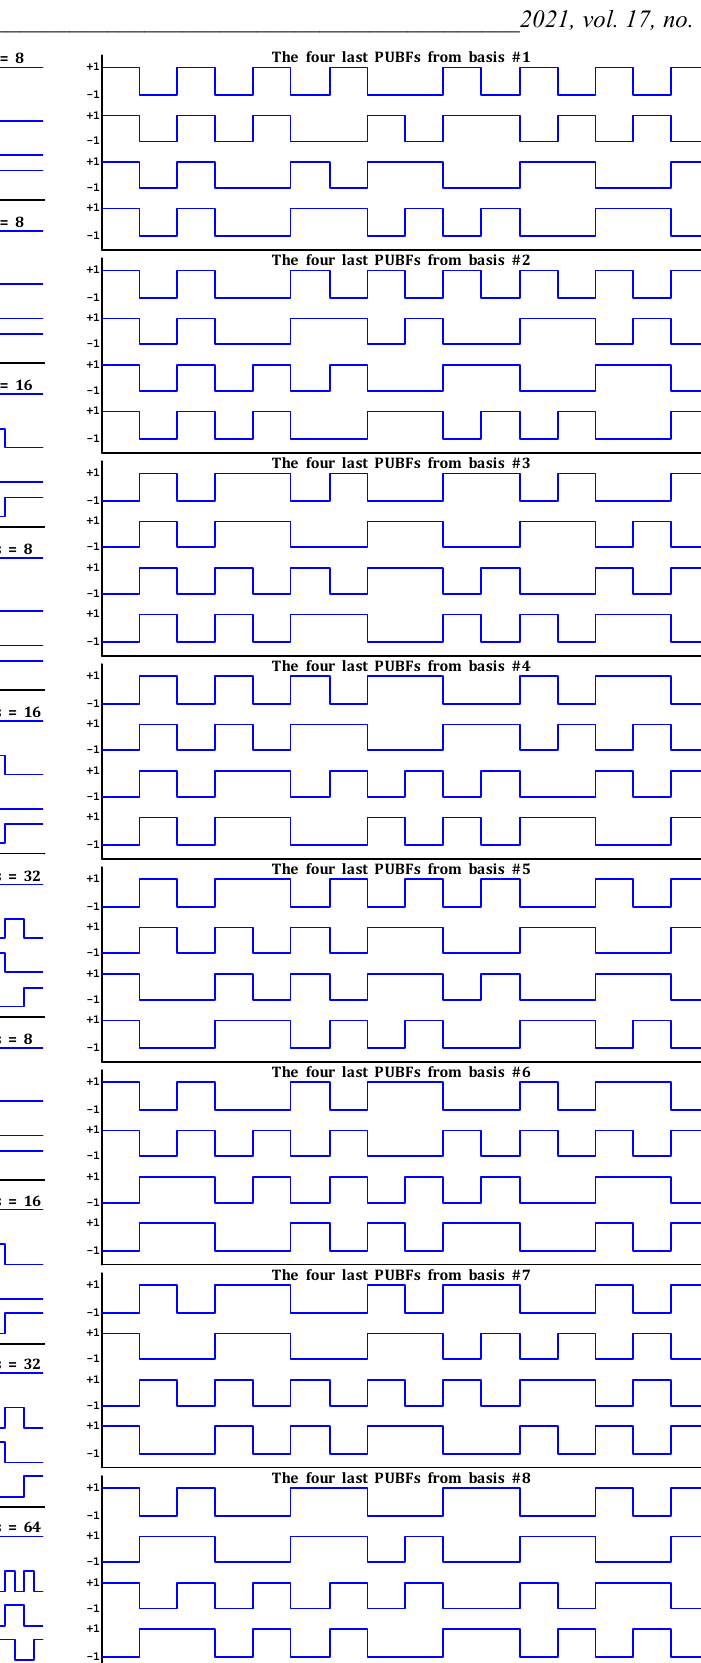
Fig. 2. The four last PUBFs (sequences) from each of the eight bases of 16 functions in a 4×4 MIMO system for the frame of 72, 144, or 288 symbols, where 16 pilot symbols per frame are used). Unlike the 4×4 MIMO system with Walsh sequences, the meanders here have roughly the same